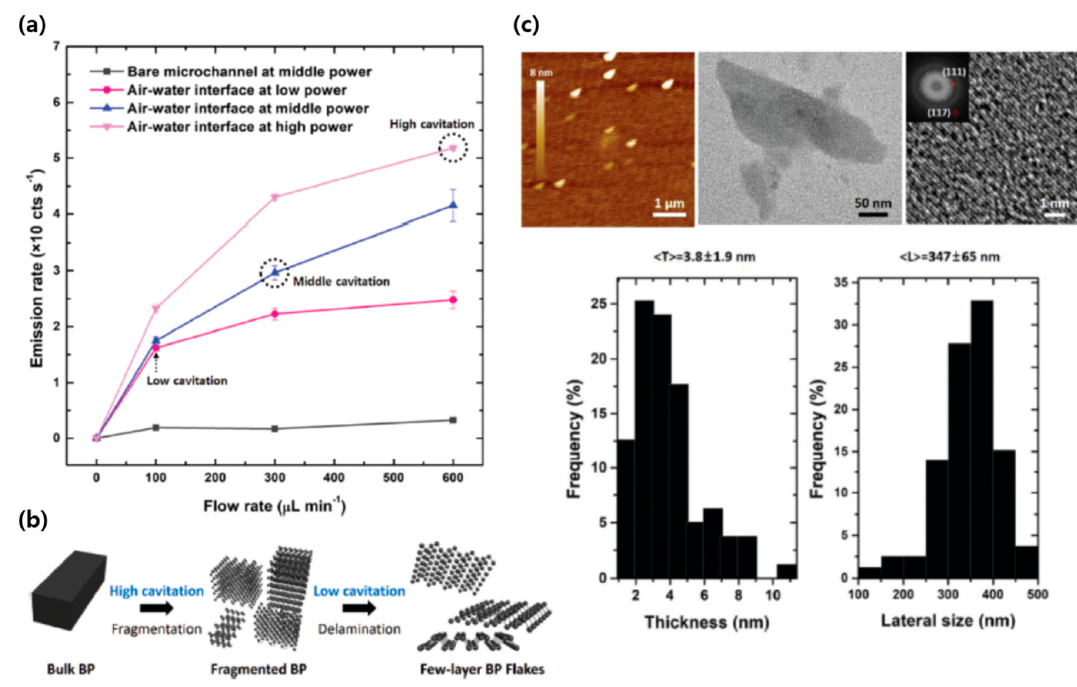
Figure 10. ( a ) Cavitation e ff ects concerning flow rate and power density of sonication (emission rate in the y-axis corresponds to cavitation e ff ects), ( b ) schematic of fragmentation and delamination of BP under controlled cavitation e ff ects in the superhydrophobic SiNW microfluidic device, and ( c ) AFM, (HR)TEM, and size distribution histogram of few-layer BP nanosheets. Reprinted with permission from reference [25], copyright 2020, Royal Society of